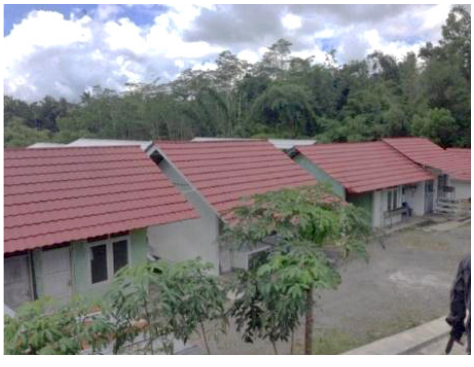
Figure 4. Houses